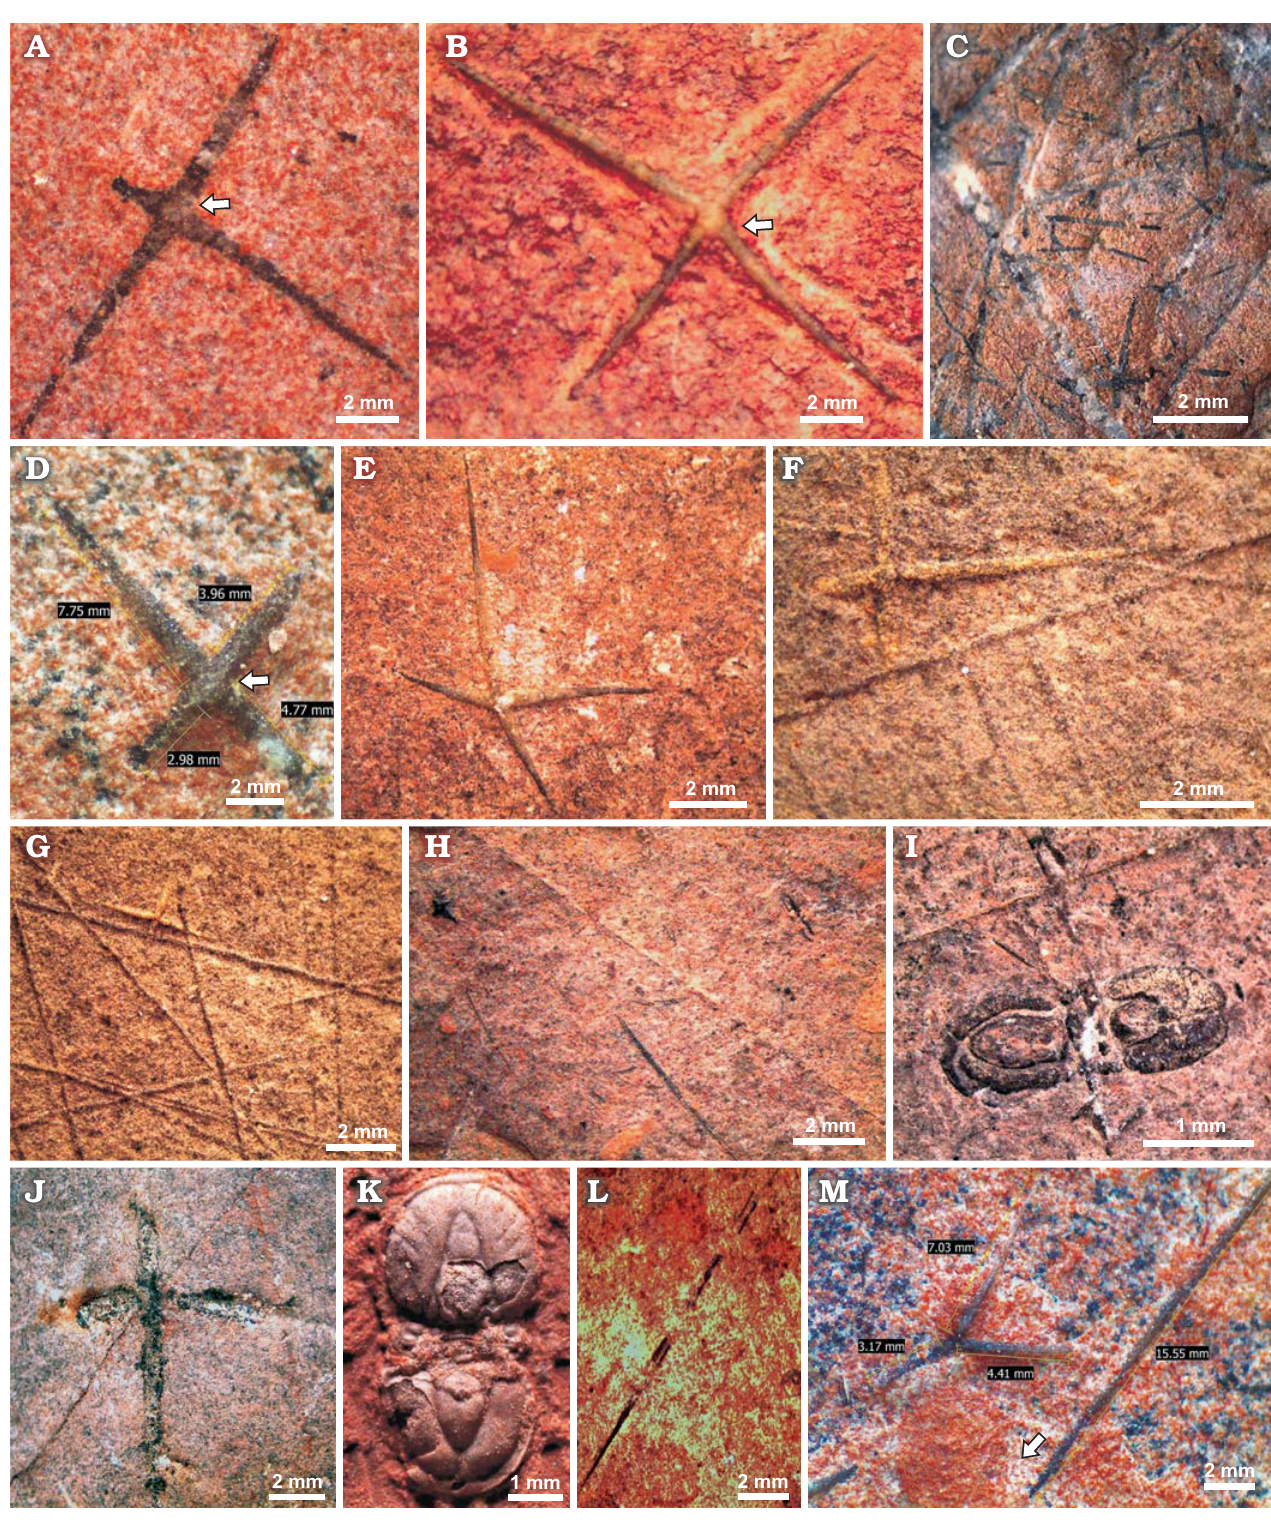
Fig. 6. Isolated spicules and associated fossils from the middle Cambrian El Mogallón Formation at Cerro El Mogallón, Sonora, Mexico. A , B , D . Spicules exhibiting 90° angles between four coplanar rays, and a vestigial fifth perpendicular ray, preserved as a central boss (arrows), indicating a geometry of three orthogonal axes. C . Assemblage of diverse disarticulated spicules. E . Stauractine with three smooth equal long rays and the forth longer. F , G . Fragments of possibly semi-articulated skeleton composed of stauractines and monaxons, with traces of a sub-regular, perhaps quadruled array. H . Fine monaxial spicules. I . Unidentified agnostoid trilobite and a typical cruciform stauractine. J . Possible anchoring spicule with two strongly re- curved rays. K . Ptychagnostus atavus (Tullberg, 1880). L . Isolated, partial, presumed root tuft with two long parallel monaxons. M . USDG 001, triactine ( Kiwotinokia ) and a long isolated monaxon; the arrow points to a possible ovoid